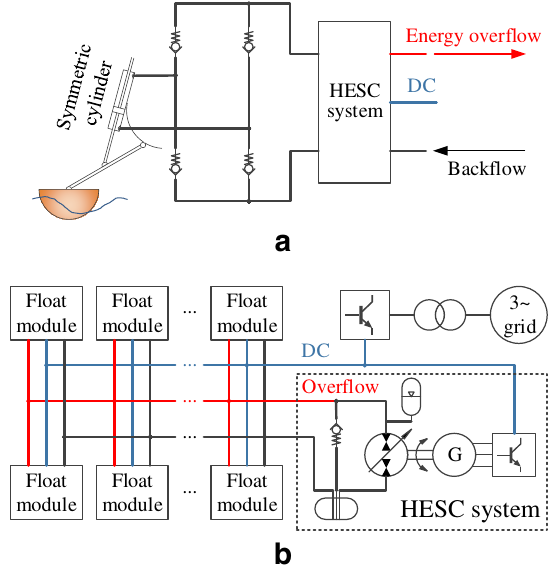
Fig. 3 PTO system with HESC system integrated. a Float module with HESC system. b HESC subsystem handling the overflow energy of PTOs Fig. 4 Power profile at sea state 3, for the WaveStar